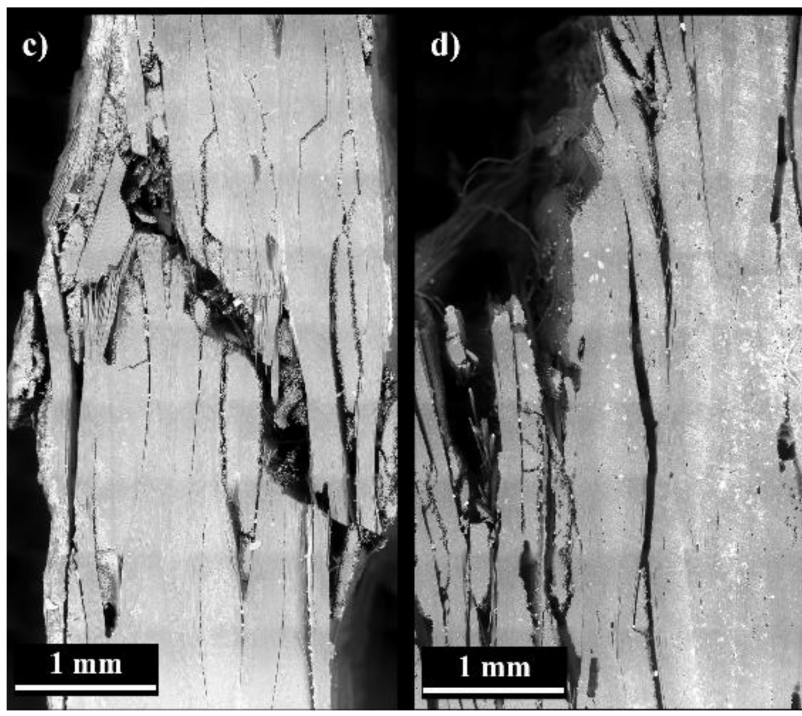
Figure 6. SEM images of the gage section of PW composites after compression testing under different environmental temperatures: ( a ) room temperature, ( b ) 100 ◦ C, ( c ) 200 ◦ C, and ( d ) 300 ◦